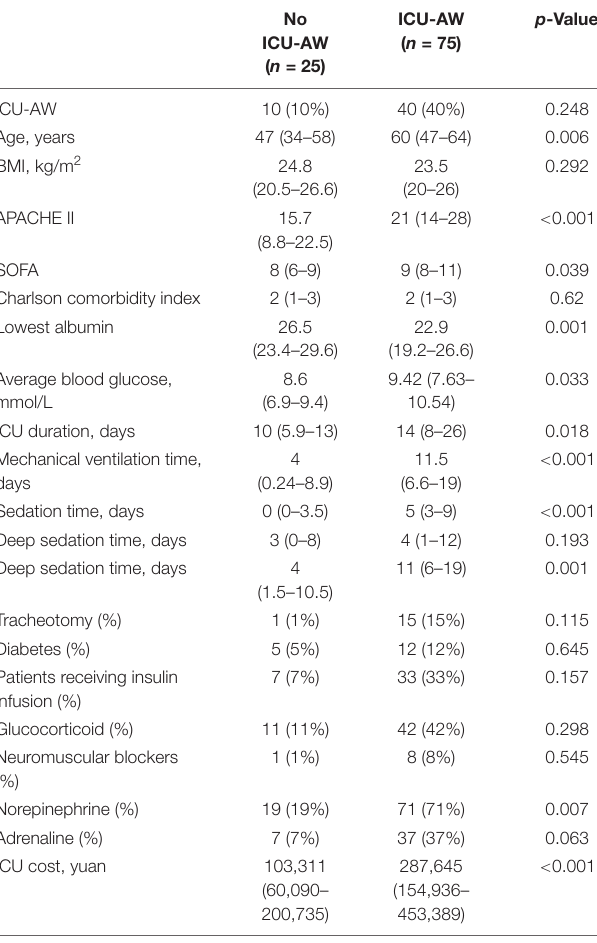
TABLE 6 | Logistic regression analysis of combined